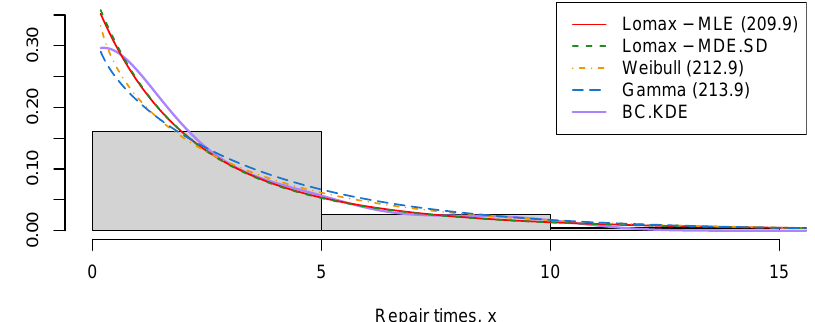
Figure 3. The kernel density estimate and fitted density functions based on the airborne commu- nication transceiver repair time data (AIC values for the MLE estimated distributions provided in parentheses in the legend).